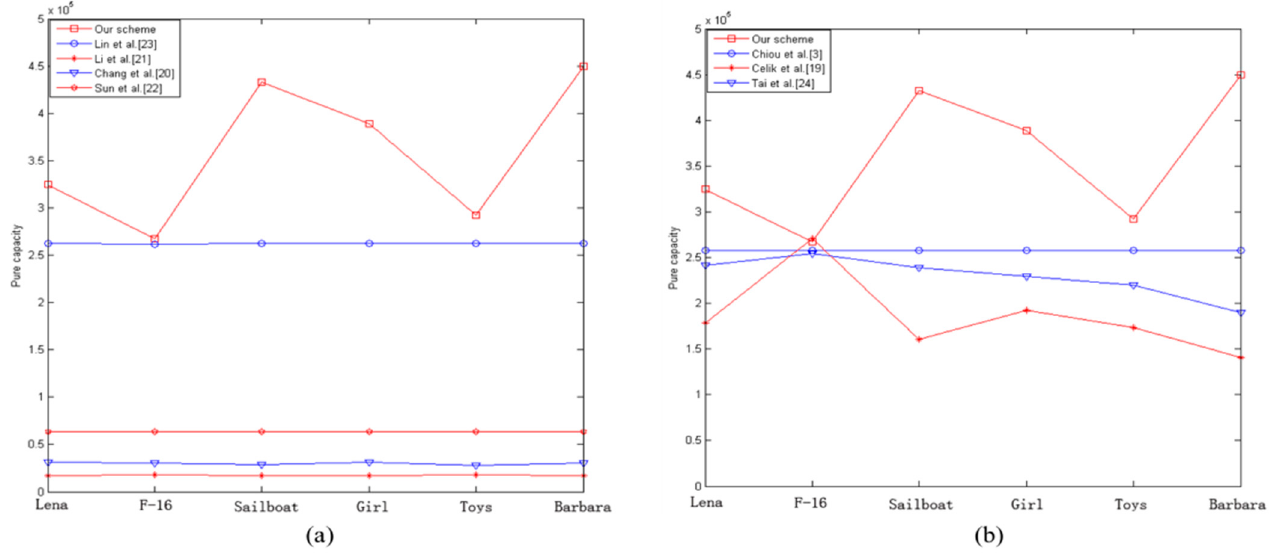
Figure 9. Comparative performance of pure hiding capacity for six test images between our method and other methods. ( a ) Comparisons with ours and other schemes based on BTC and ( b ) comparisons with ours and other schemes which are not based on BTC. Table 2. Comparative performance of PSNR (dB) for six test images between our method and other methods base on BTC.